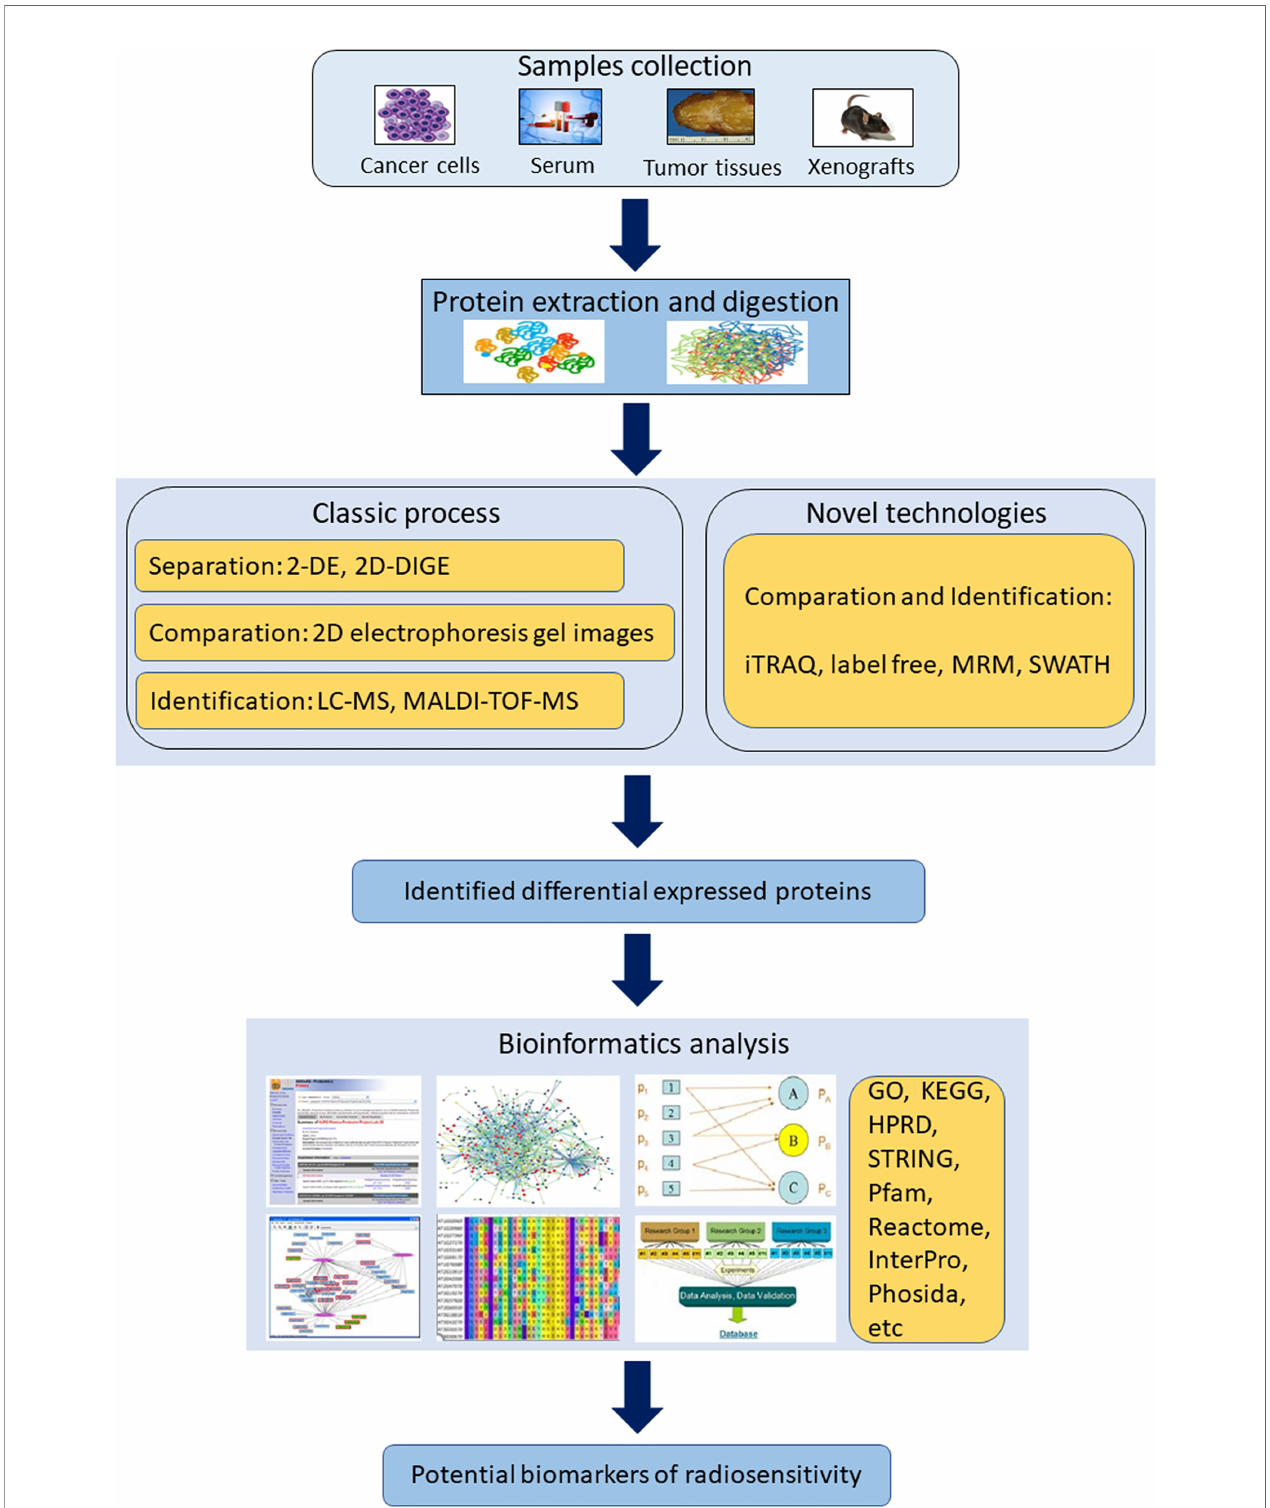
FIGURE 2 | Scheme of the work fl ow and methodological strategies for proteomics application in identifying radiosensitivity biomarkers. (2-DE, two-dimensional gel electrophoresis; 2D-DIGE, two-dimensional difference gel electrophoresis; GO, The Gene Ontology; HPRD, human protein reference database; iTRAQ, isobaric tags for relative and absolute quantitation; KEGG, Kyoto Encyclopedia of Genes and Genomes; MALDI-MS, matrix-assisted laser desorption ionization mass spectrometer; MRM, multiple reaction monitoring; SWATH, sequential window acquisition of all theoretical fragment ion spectra).